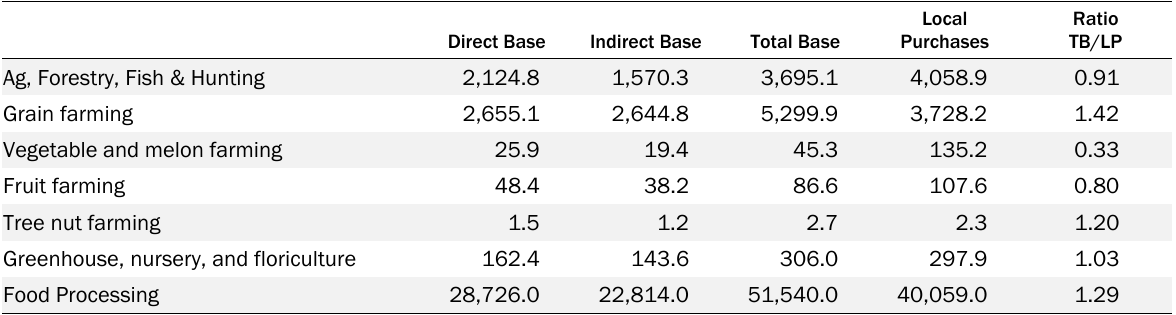
Table 4. Base versus Gross Output (US$